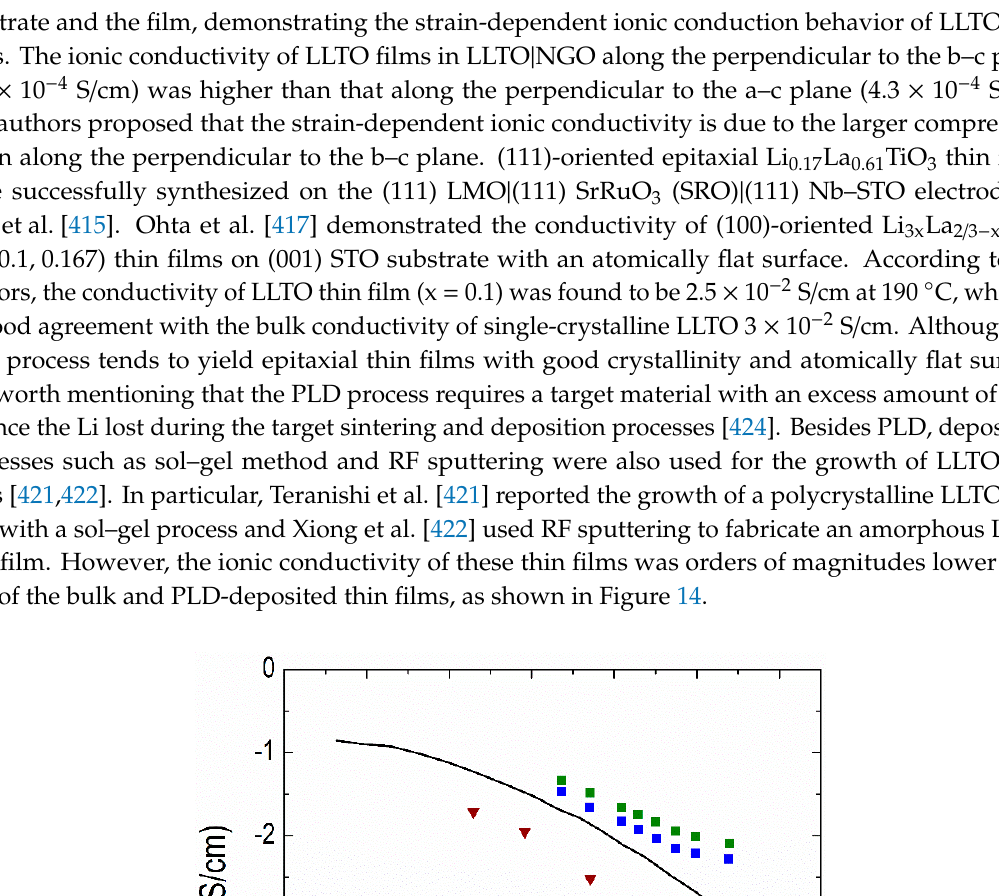
Figure 14. Conductivity summary of bulk [426] and thin-film Li x La 2/3 − 1/3x TiO 3 (LLTO) deposited